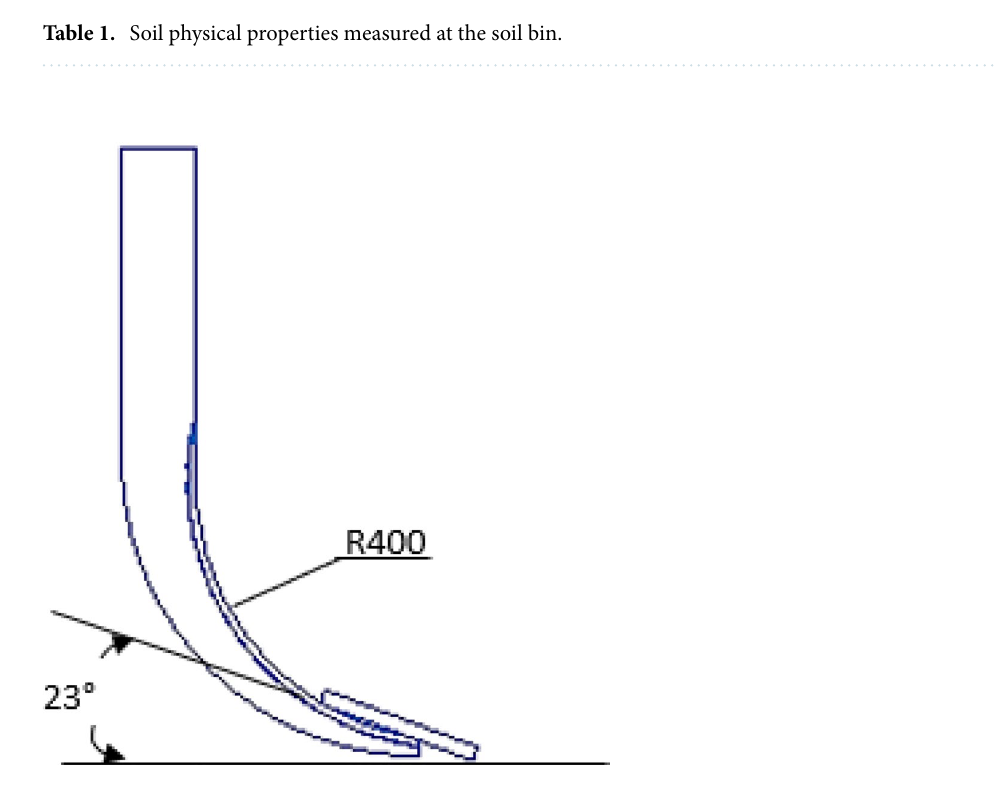
Figure 1. Schematic diagram of the subsoiler